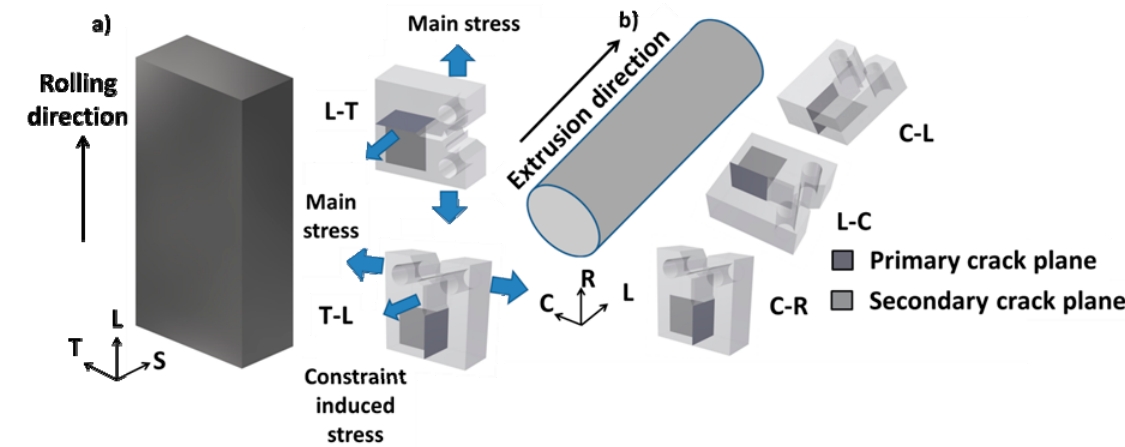
Figure 2. A schematic illustration of main stress and constraint induced stress in C(T) specimens in ( a ) two orientations of hot-rolled specimen and ( b ) three orientations of hot-extruded specimen indicating primary and secondary crack planes.